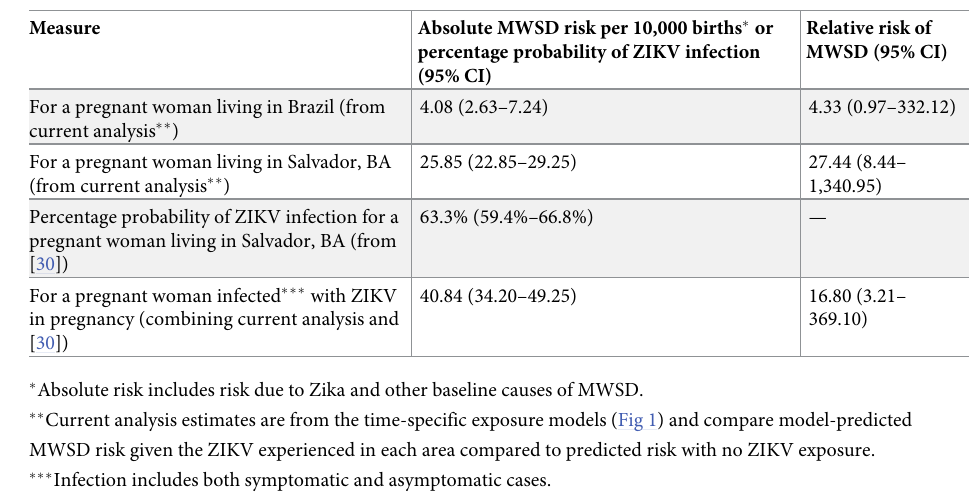
Table 1. Estimated individual-level risk of